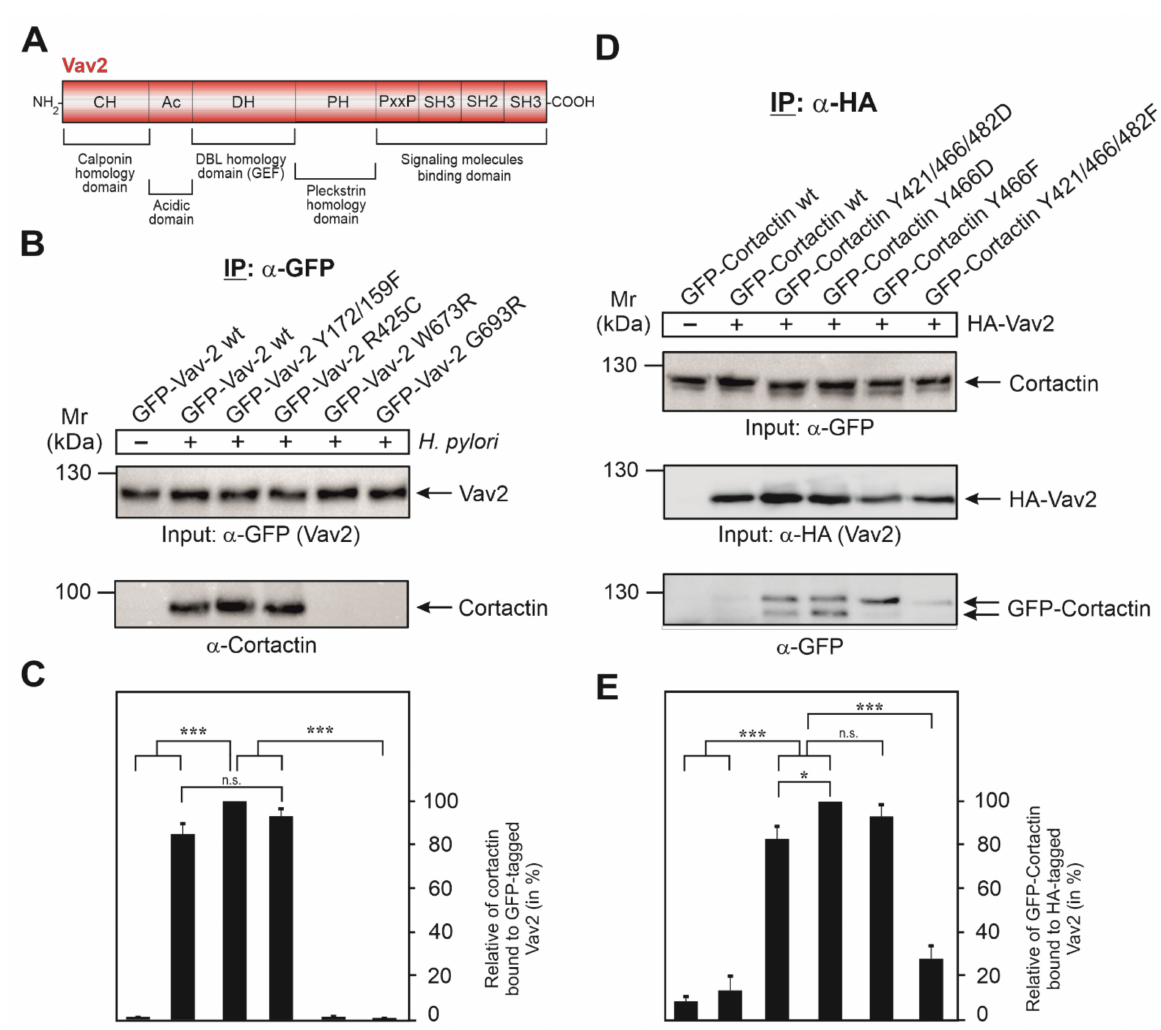
Figure 5. Vav2 binds via its SH2 domain to cortactin phosphorylated at Y-470. ( A ) Schematic representation of the Vav2 domain structure.. ( B ) AGS cells were transfected with GFP-Vav2 wt and various GFP-Vav2 mutant constructs, as indicated, for 48 h, followed by infection with H. pylori for 6 h. Cell lysates were harvested and subjected to IP using α -GFP antibodies to precipitate GFP-Vav2. Similarly, presence of each construct in the IPs was confirmed by α -GFP antibody Western blot (top). This blot was then re-probed with α -cortactin antibody. ( C ) Densitometric quantification of cortactin band intensities bound to precipitated GFP-Vav2. ( D ) AGS cells were transfected with GFP-cortactin wt and various GFP-cortactin phospho-mutant constructs, as indicated, for 48 h in the presence or absence of HA-tagged Vav2 plasmid. Total cell lysates were probed with α -GFP antibodies showing similar amounts of GFP-cortactin proteins present in each lane (top). Parallel samples were subjected to IP using α -HA antibodies to precipitate HA-tagged Vav2 (middle). This blot was then re-probed with α -GFP antibodies to detect bound cortactin (bottom). ( E ) Densitometric quantification of cortactin band intensities bound to precipitated HA-Vav2. The results show that cortactin and Vav2 can bind to each other by a typical phosphotyrosine-SH2 domain interaction. Error bars represent +/ − standard deviation (SD). The results are from three independent experiments. p -values of ≤ 0.05 (*), and ≤ 0.001 (***) were considered as statistically significant. n.s.: not